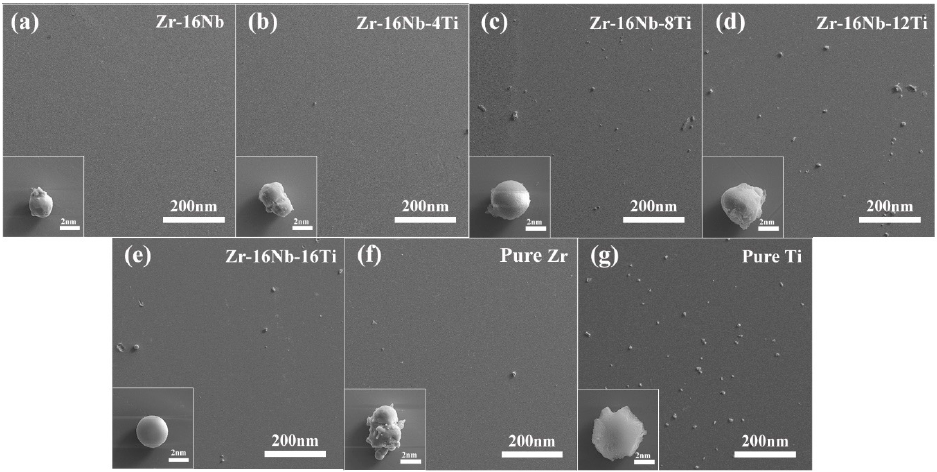
Figure 10. Platelet adhesion situation on the Zr-16Nb-xTi and reference alloys under the magnification times of 60× (inset is the morphology of platelets under 2000× times magnification): ( a ) Zr-16Nb; ( b ) Zr-16Nb-4Ti; ( c ) Zr-16Nb-8Ti; ( d ) Zr-16Nb-12Ti; ( e ) Zr-16Nb-16Ti; ( f ) Pure Zr; ( g ) Pure Ti.